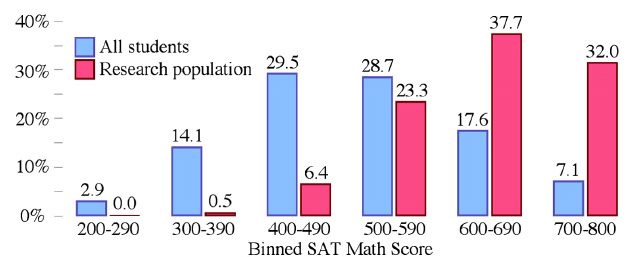
FIG. 4. Binned comparison of SAT Math scores for all college- bound students with students at universities where most PER is conducted. The blue bars are the SAT Math scores for all students who took the SAT in Spring 2016, collected into 100-point bins and given as a percent of all students taking the exam. The red bars are for students at the 39 universities where most PER is conducted, weighted by the contribution of each university to the total number of students in our sample.